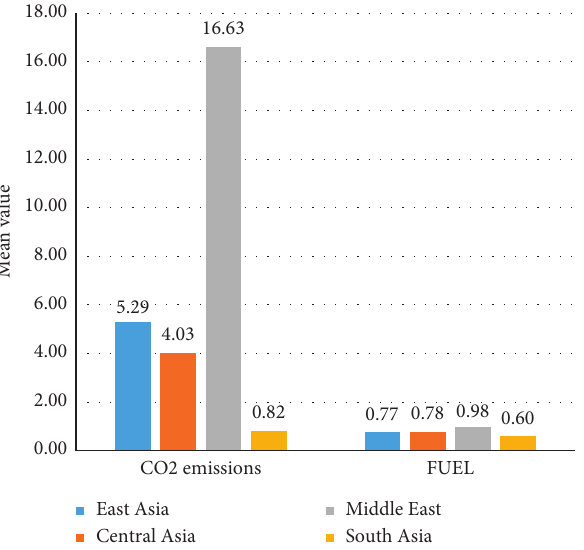
Figure 1: CO 2 emission and FUEL values in the subregions of Asia (2007–2018).